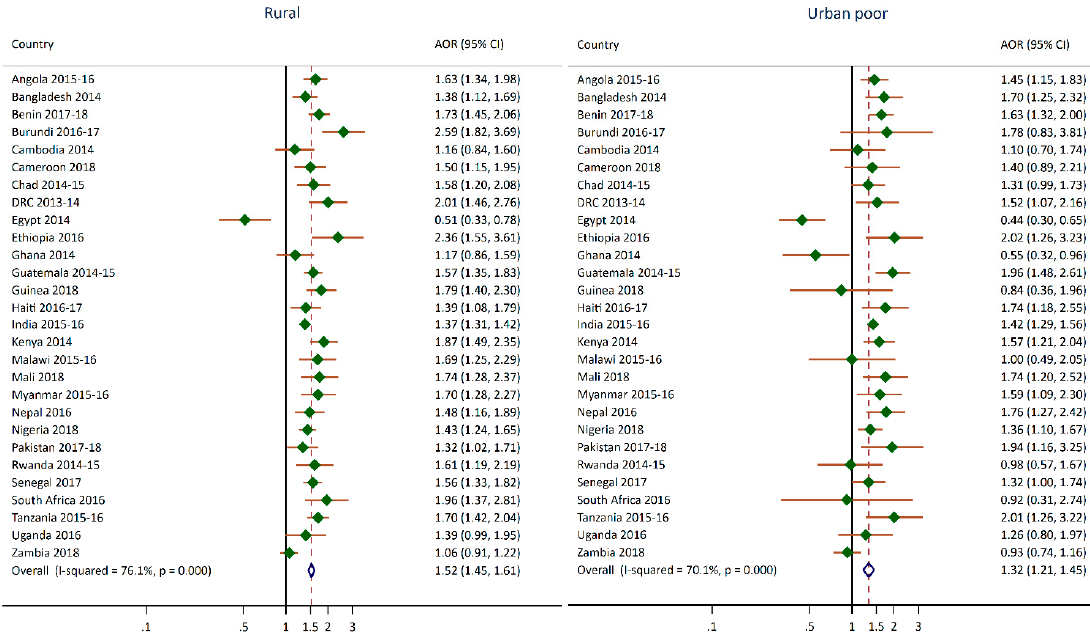
Figure 2. Adjusted odds ratios of stunting of children living in urban poor and rural clusters compared to children living in urban non-poor clusters.